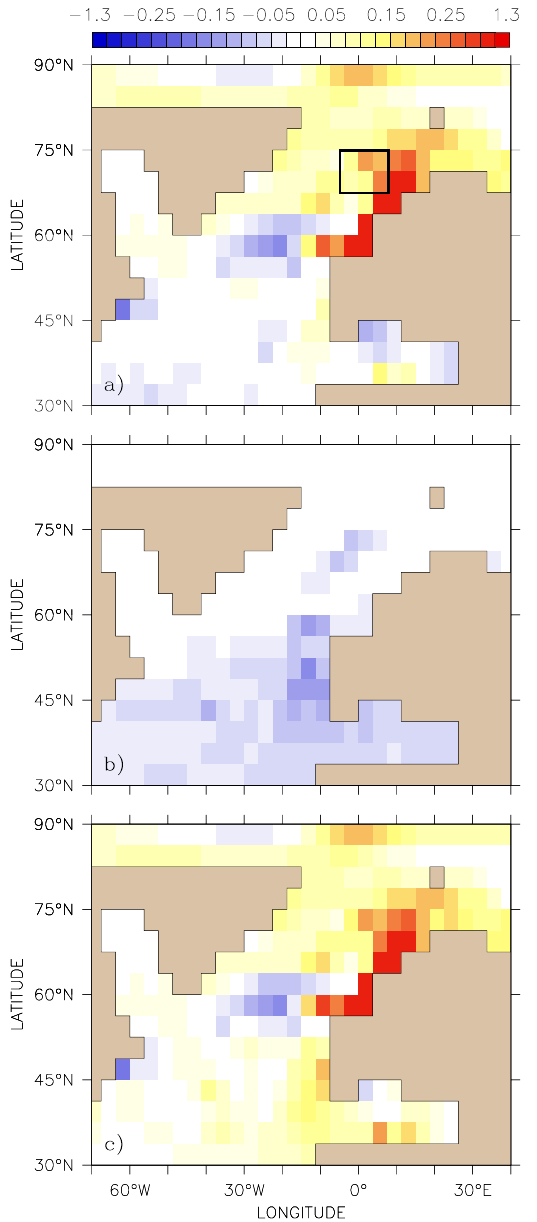
Fig. 3. (a) Surface density anomalies at the transition stage relative to the stadial regime for the CO 2 -only experiment and contribution to the latter by (b) temperature and (c) salinity in kgm − 3 , assuming a linear equation of state. The black box in panel (a) indicates the region where the surface freshwater flux balance was calculated.